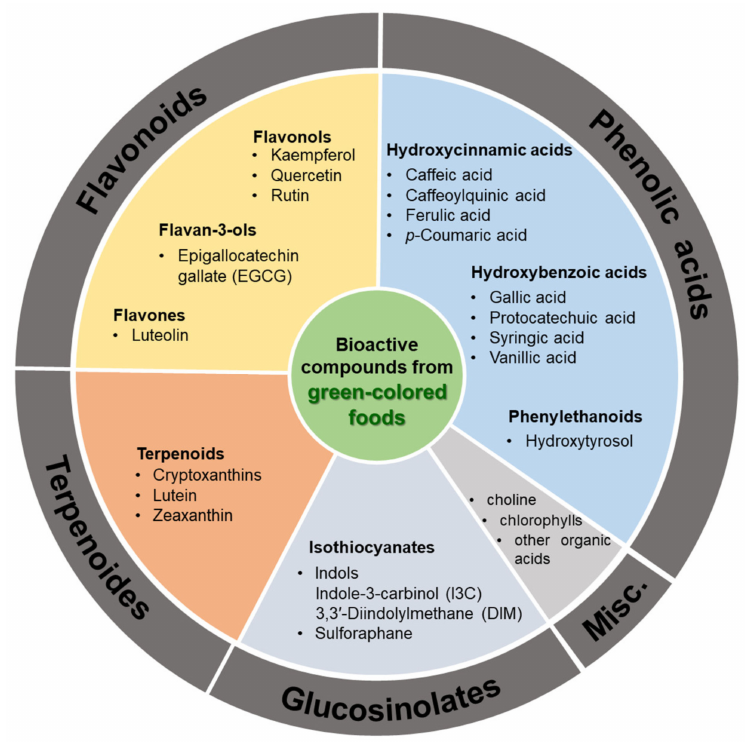
Figure 1. List of bioactive compounds derived from green-colored foods. This figure was adapted from references